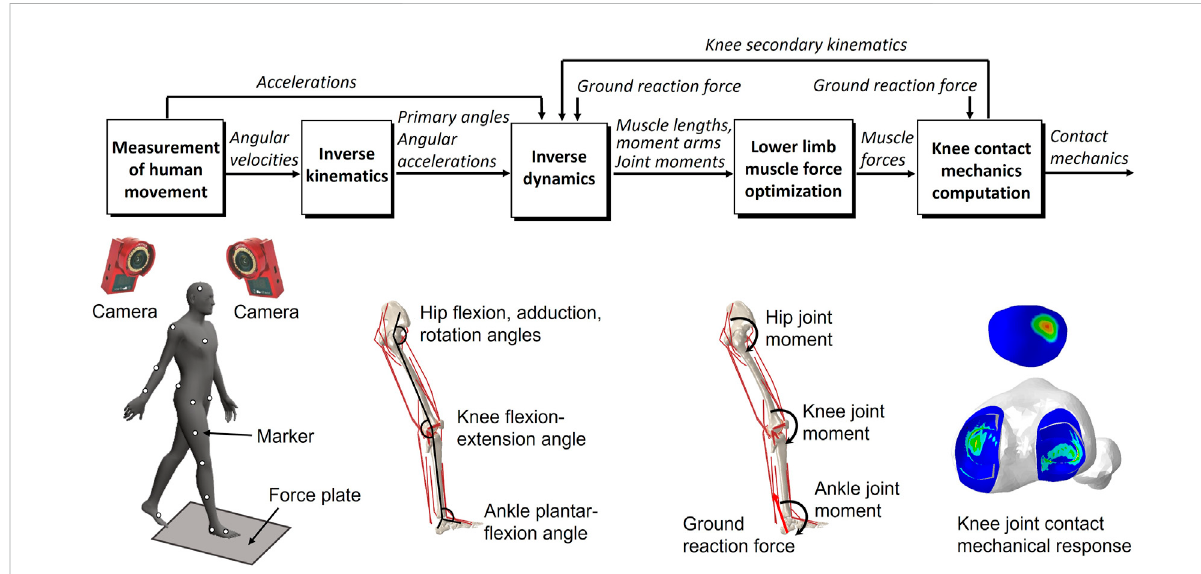
FIGURE 2 Overview of the dynamic gait simulation. Marker positions were input into the inverse kinematics to predict the joint primary angles (lumbar fl exion – extension, hip joint 3-DOF rotations, knee joint fl exion – extension, and ankle dorsi fl exion – plantar fl exion). The joint primary angles on each joint and ground reaction force measured from the force plate were input into the inverse dynamics to predict the muscle lengths, muscle moment arms, and right lower limb joint moments. The static optimization of the muscle force was performed with the joint moments, the muscle lengths, and the muscle moment arms as inputs to predict the muscle force. The knee contact mechanics were computed from the muscle forces and the ground reaction force to predict the knee joint secondary kinematics and contact mechanics. The predicted knee secondary kinematics were fed back to a new inverse dynamics analysis, and the muscle force optimization and knee contact mechanics were again computed.